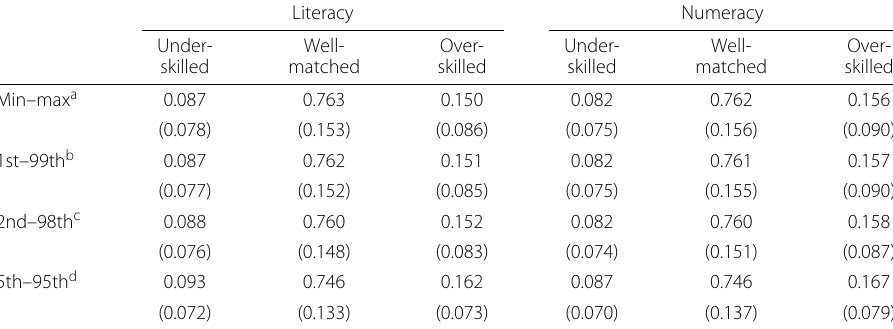
Table 8 Skill mismatch under alternative thresholds for job requirements Literacy Numeracy Under- Well- Over- Under- Well- Over- skilled matched skilled skilled matched